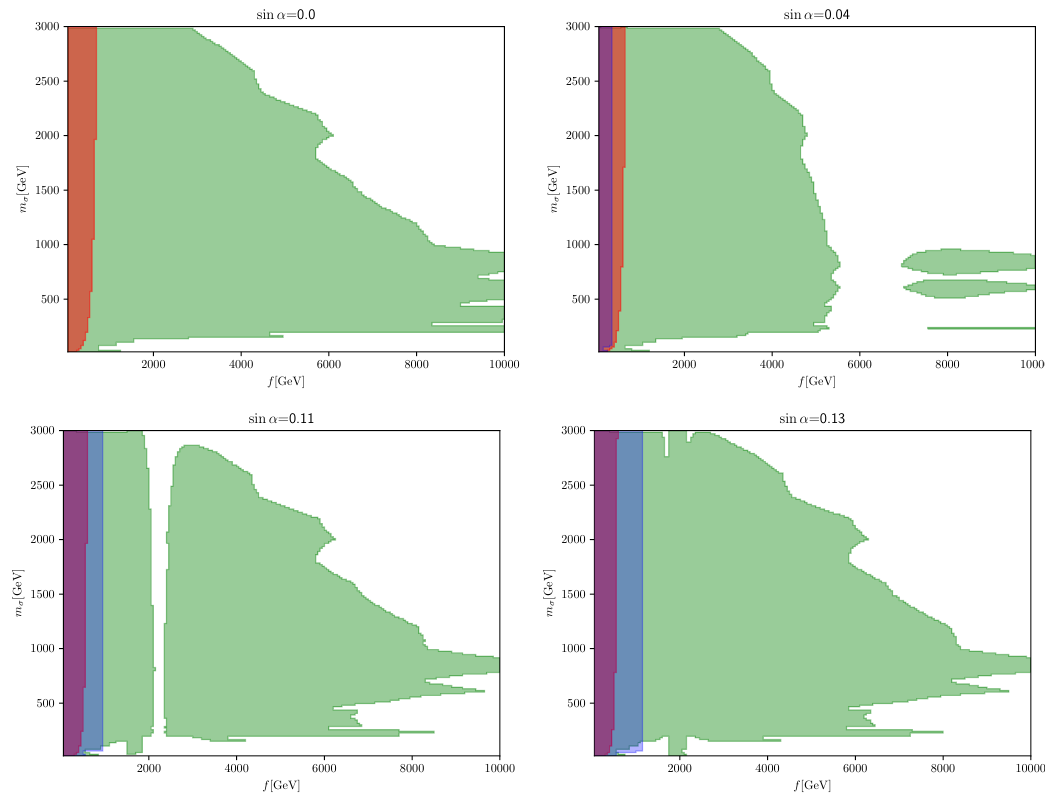
Figure 2 . Excluded regions of the model parameter space, presented in the ( f; m (cid:27) ) plane for a selection of mixing angles, with the ‘minimal mixing term’ treatment of the Higgs-dilaton mixing. We include 99% con(cid:12)dence level exclusions from Higgs measurements (blue) and the electroweak S and T parameters (red/purple), as well as 95% con(cid:12)dence level bounds from heavy scalar searches (green). The parameter scans were done using Lilith and HiggsBounds . Our (cid:12)ndings demon- strate that for su(cid:14)ciently low positive mixing angles, a gap in the exclusion emerges around the value f that satis(cid:12)es v = f = tan (cid:11) . In this gap, the couplings of the heavy scalar to the